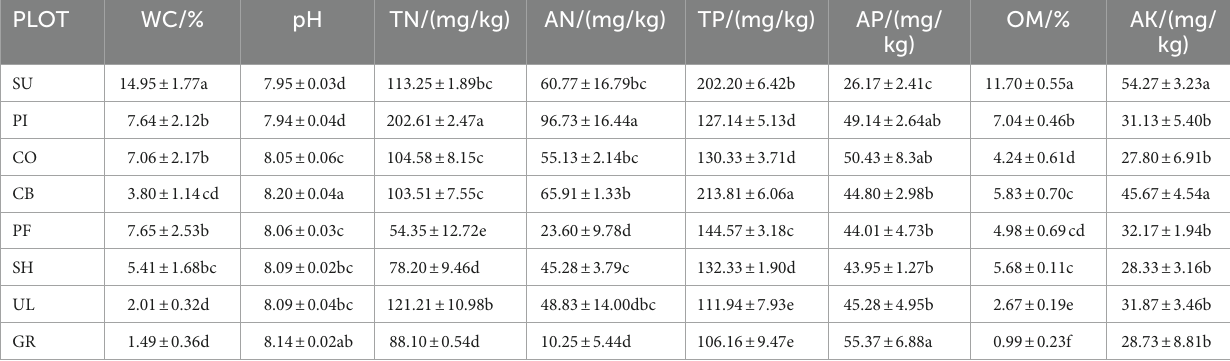
TABLE 2 Physico-chemical properties of soil at different altitudes. PLOT